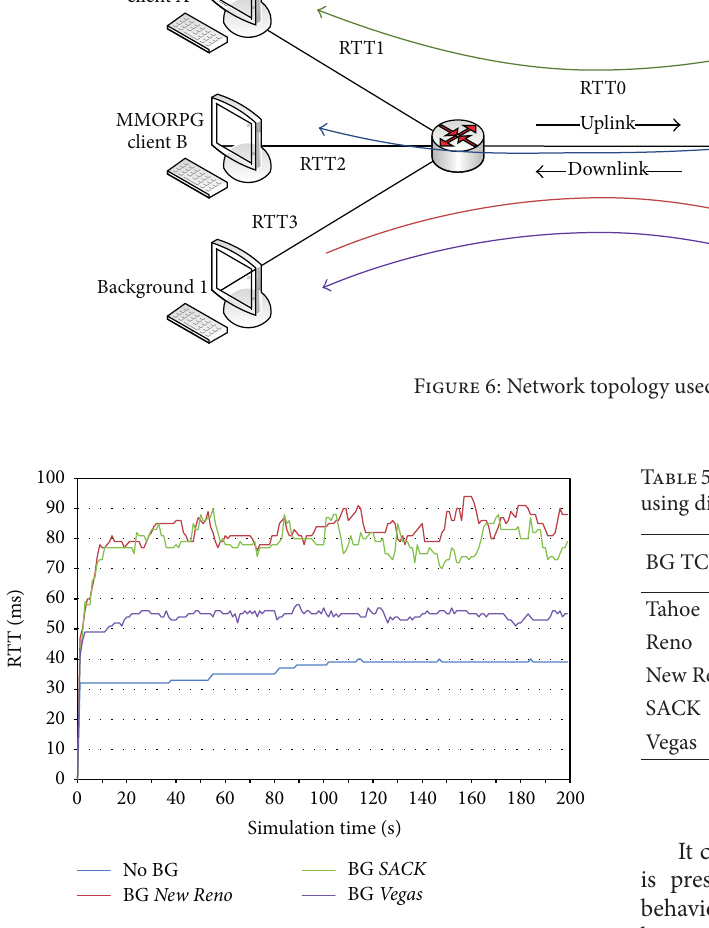
Figure 7: Competition of MMORPG versus FTP traffic for different TCP variants: smoothed RTT of a game flow. Table 4: Average RTT between all the game flows when different TCP variants are used for the background traffic.